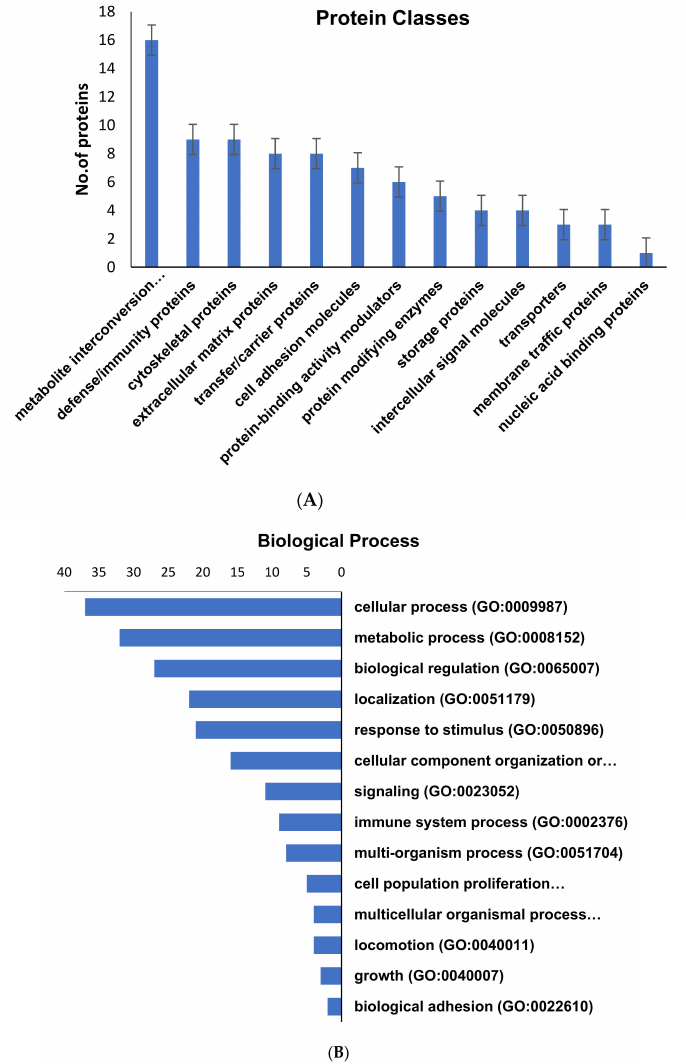
Figure 2. Gene ontology (GO) functional enrichment analysis of the identified proteins from GCT analysis performed by DAVID v6.8.24 with the GO terms of FDR < 0.01 ( A ) Protein Classes ( B ) Biological